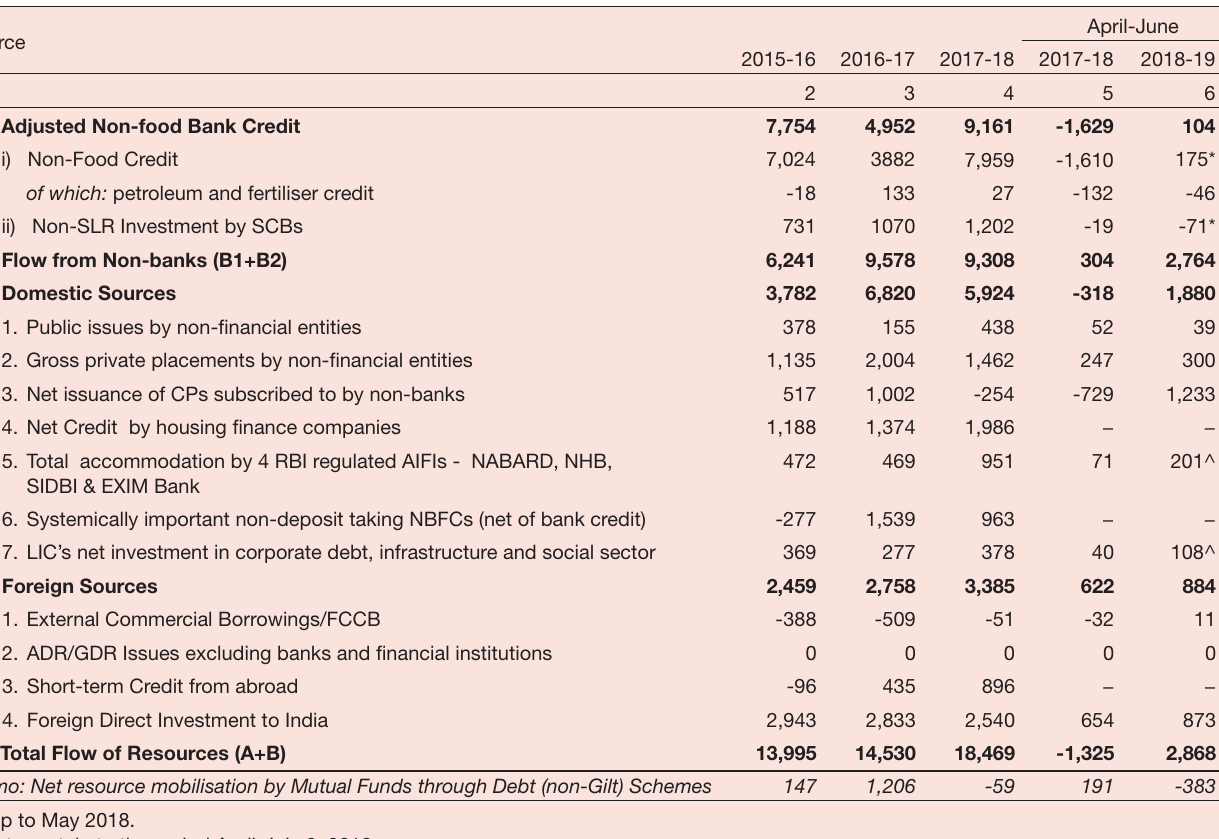
Table II.3.3: Flow of Financial Resources to commercial